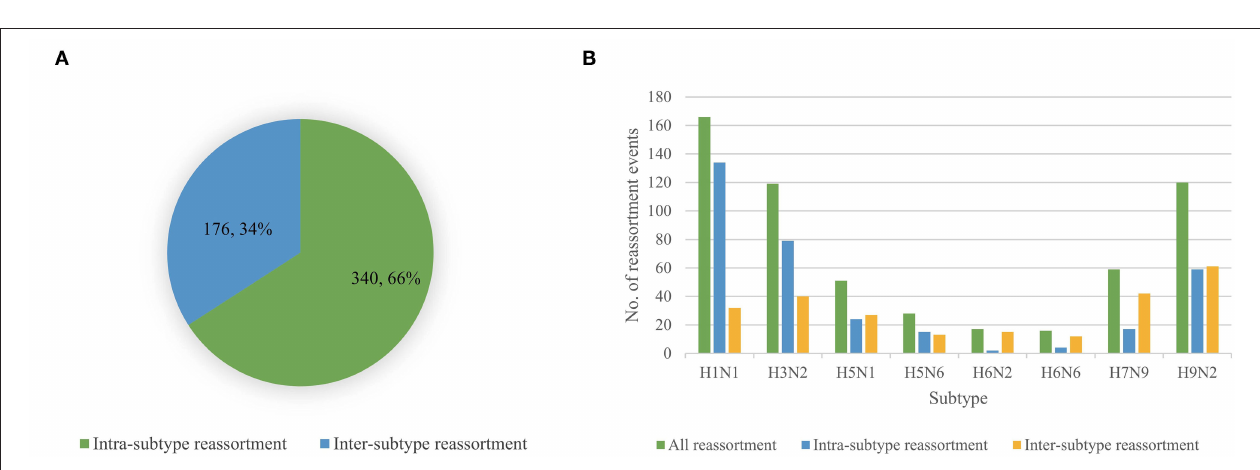
cases of H9N2 providing internal segments for H5N1.